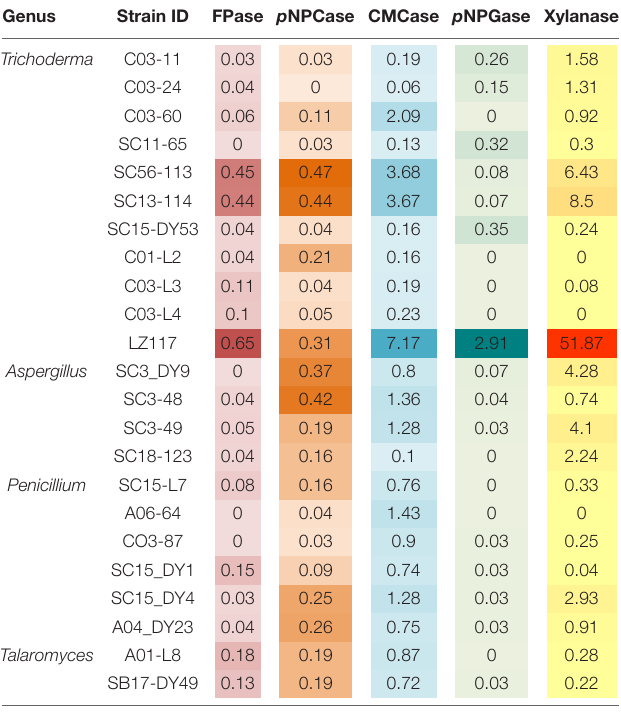
∗ The change of table background color from light to dark in each row represents the transition from low enzyme activities to high enzyme activities.